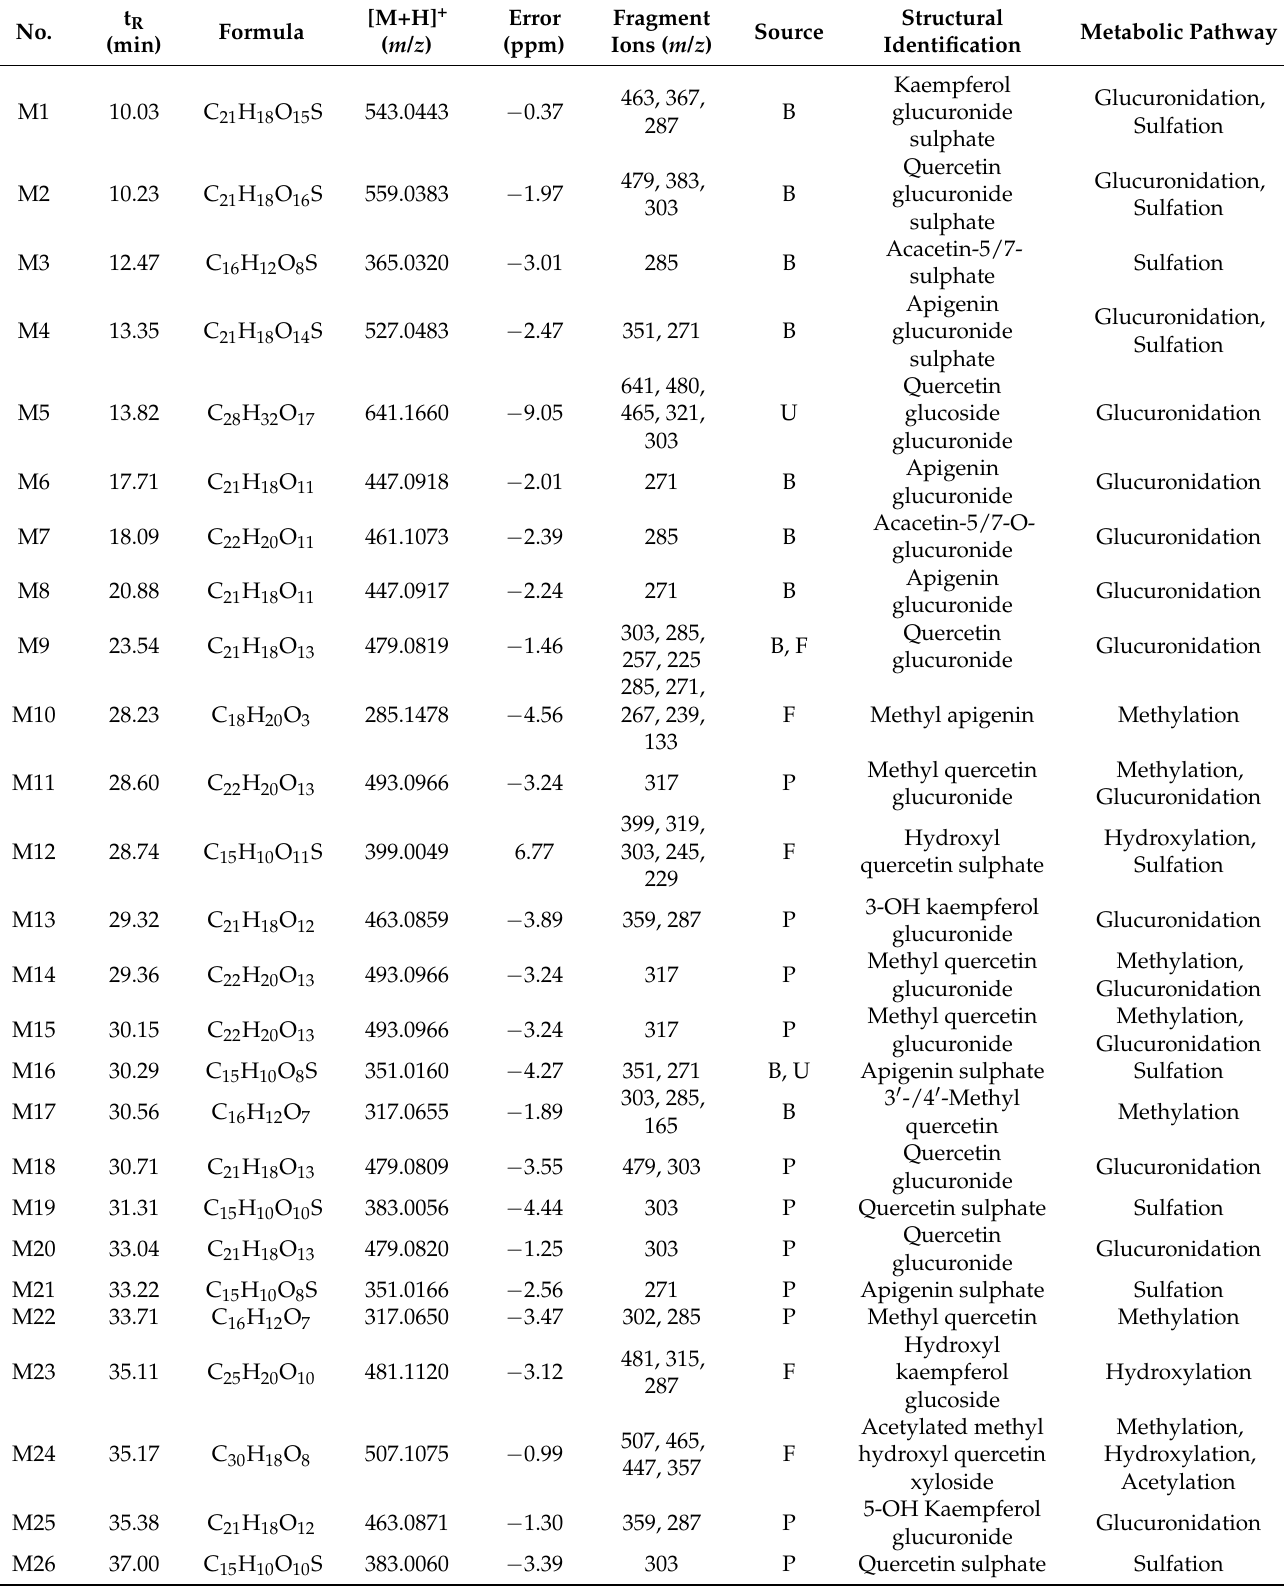
Table 2. Summary of the metabolites of Tartary buckwheat extracts in rat plasma (P), bile (B), urine (U) and feces